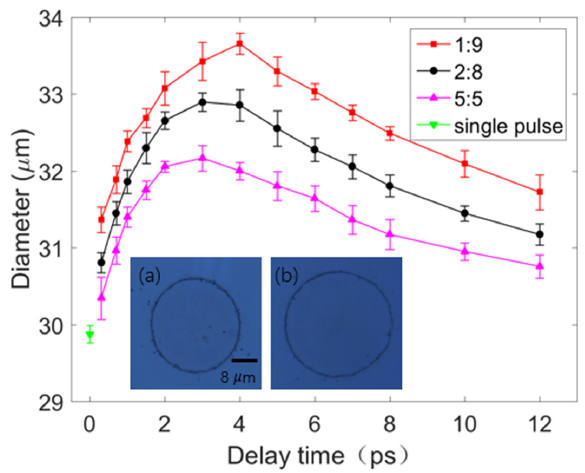
Figure 3. A comparison of the diameters of the craters ablated by the double pulses (with three energy ratios) and single pulse. The red, black, and pink lines represent the results obtained for double pulses with energy ratios of 1:9, 2:8, and 5:5, respectively. The downward green triangle represents the results obtained for the single pulse. Inset ( a )—image of a crater ablated by the single pulse; inset ( b )—image of a crater ablated by double pulses with an energy ratio of 1:9 and a delay time of 4 ps. Insets ( a , b ) have the same scale